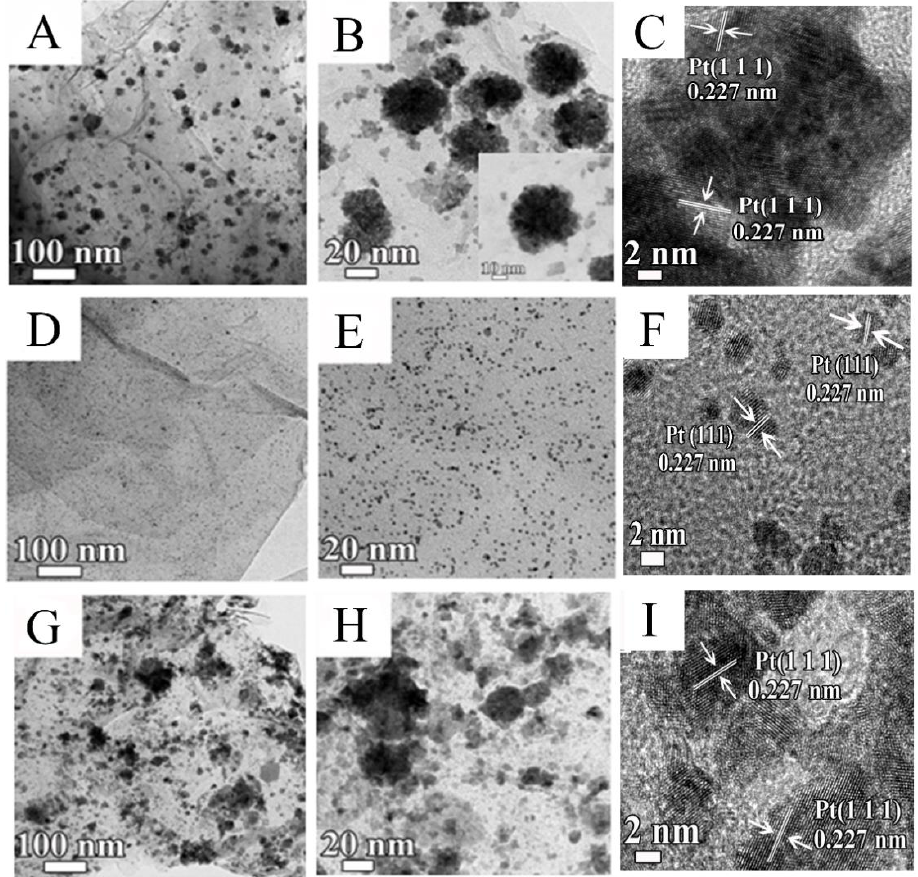
Figure 2. Transmission electron microscopy (TEM) images: Pt-Bi (Bi 2 O 3 )/GNs (PVP) ( A , B ), Pt/GNs (PVP) ( D , E ) and Pt-Bi (Bi 2 O 3 )/GNs ( G , H ); The inset in panel B is magnified TEM images of Pt-Bi (Bi 2 O 3 )/GNs (PVP); High-resolution transmission electron microscopy (HRTEM) images: Pt-Bi(Bi 2 O 3 )/GNs (PVP) ( C ), Pt/GNs (PVP) ( F ) and Pt-Bi (Bi 2 O 3 )/GNs ( I ).